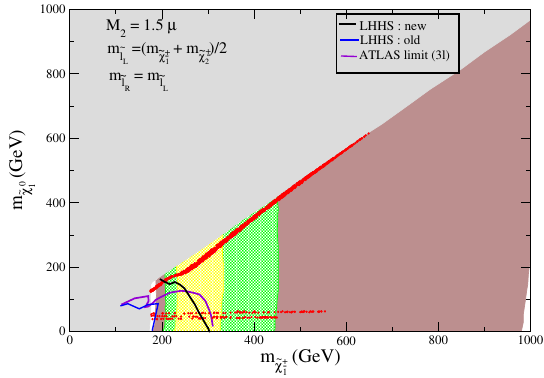
Figure 3 . Plot in m (cid:0) m plane in Light Higgsino and Heavy Slepton (LHHS) model. The (cid:6) e (cid:31) 0 1 e (cid:31) 1 black contour is for the non-decoupled scenario whereas the blue one is for the decoupled scenario (see text for details). The magenta line is the exclusion contour as obtained by ATLAS in case of LWHS Model. Colors and conventions are same as in (cid:12)gure